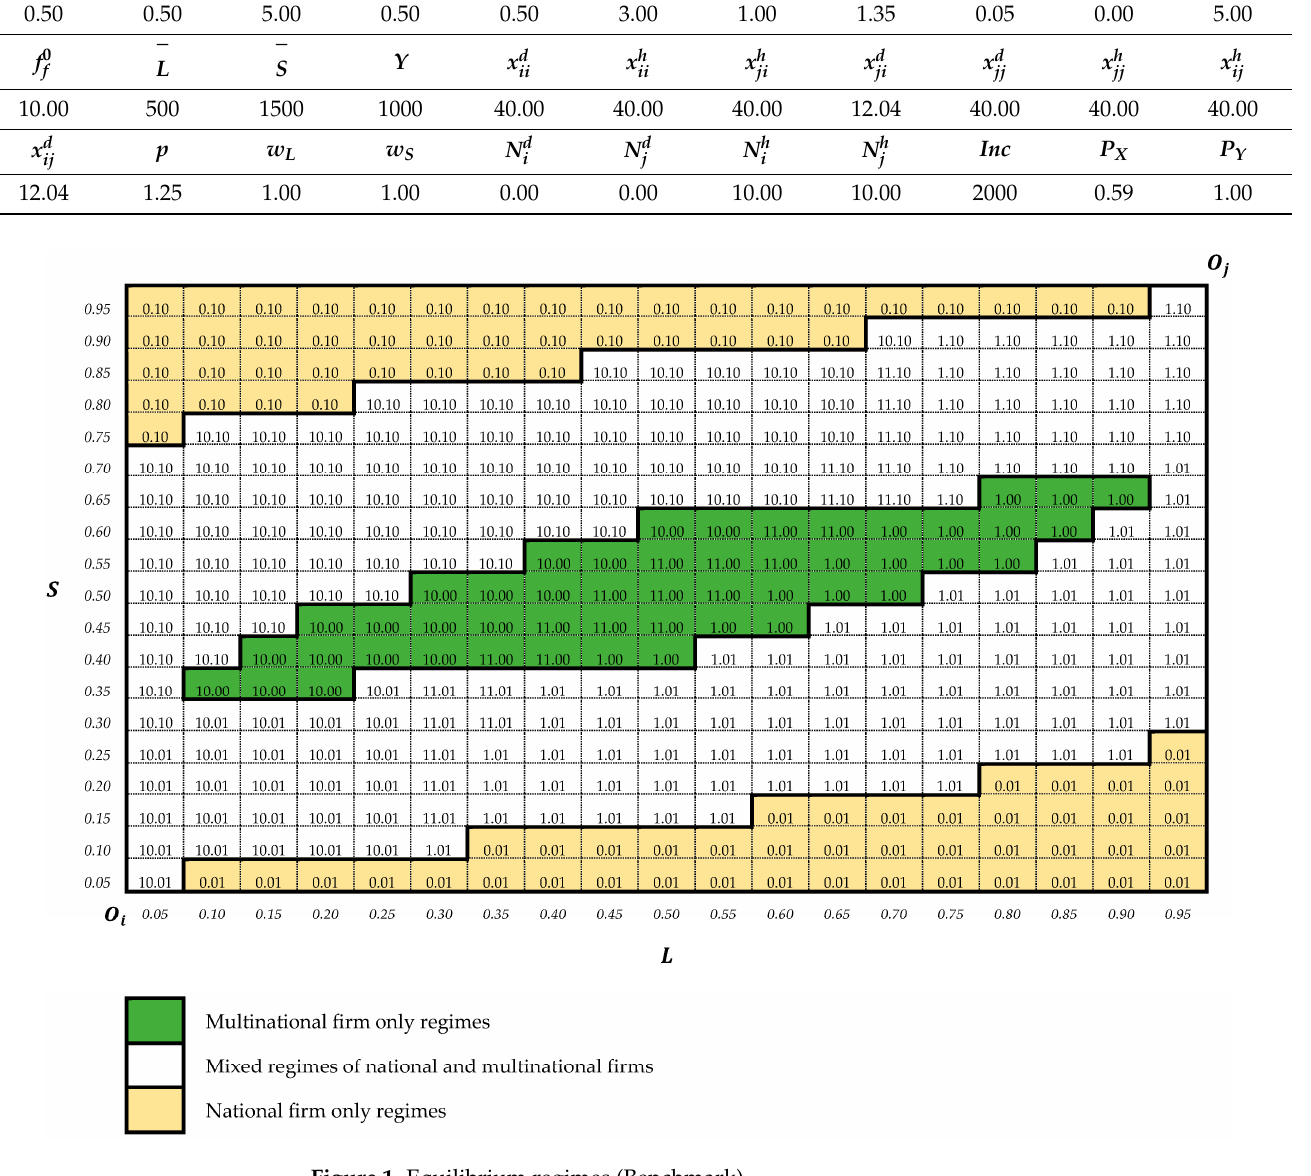
Figure 1. Equilibrium regimes (Benchmark).